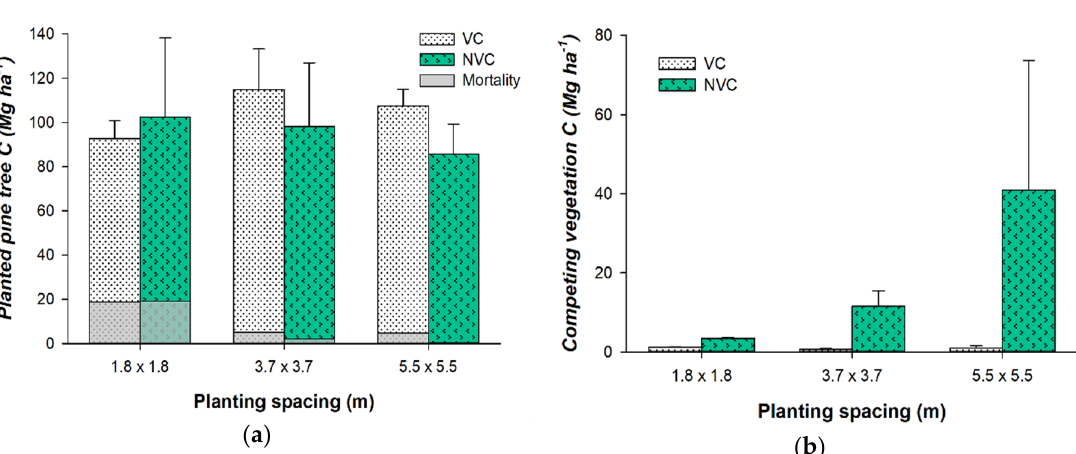
Figure 4. 54-year-old aboveground vegetation carbon (mean + sd) for ( a ) planted pine trees with mortality (shaded area) and ( b ) competing vegetation grown under three levels of pine spacing and two competing vegetation control treatments at Challenge Experimental Forest, California, USA.